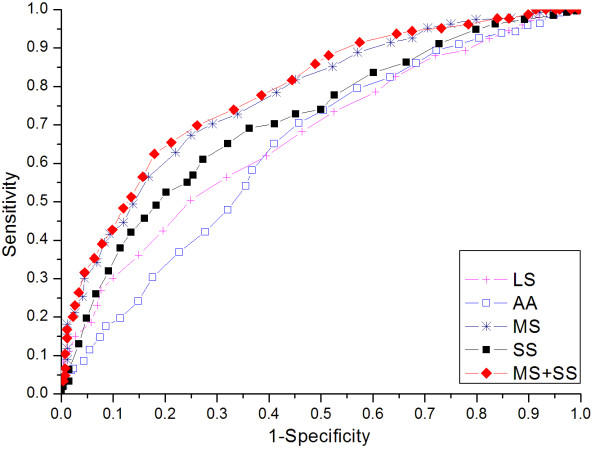
ROC Curves of five different SVM models. Five SVM models were constructed using five different sequence encoding schemes: single local sequence ("LS"), amino acid compositions of local sequence ("AA"), multiple sequence alignment ("MS"), secondary structure information ("SS"), and multiple sequence alignment with secondary structure ("MS+SS").